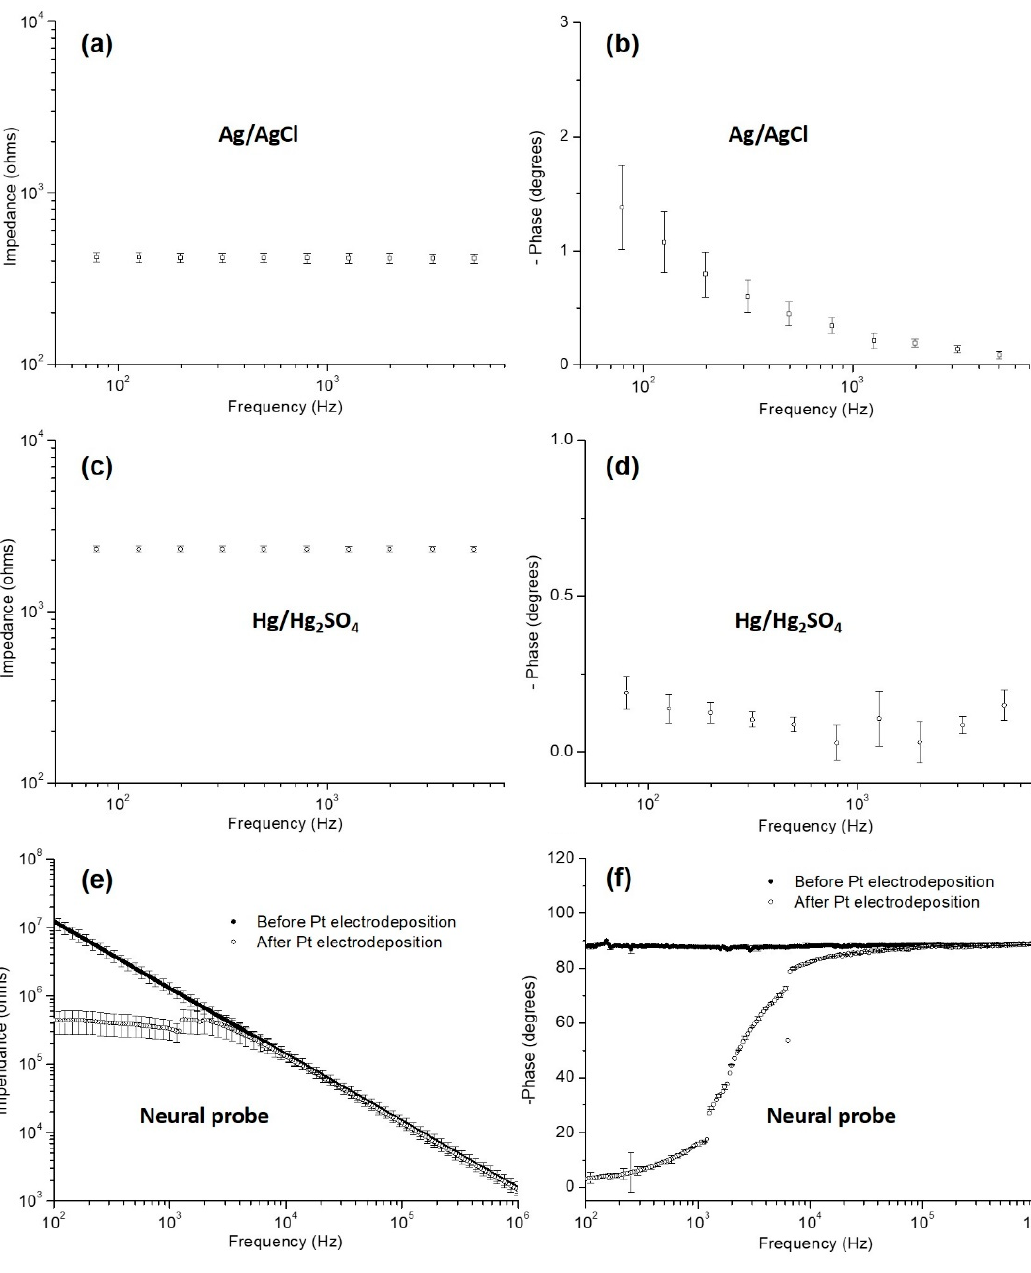
Figure 5. EIS measurement results for: Ag/AgCl reference electrode ( a , b ), Hg/Hg 2 SO 4 reference electrode ( c , d ) and neural probe microelectrodes ( e , f ).